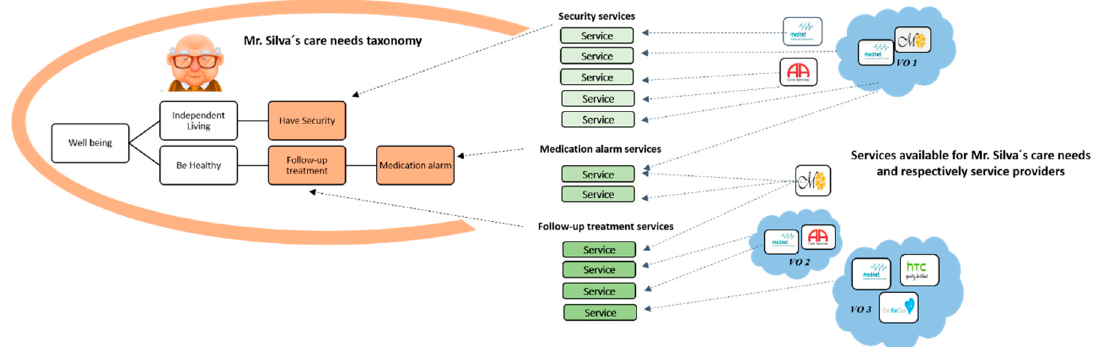
Figure 6. Mr. Silva’s care needs sub-taxonomy and available sp ij fragments.